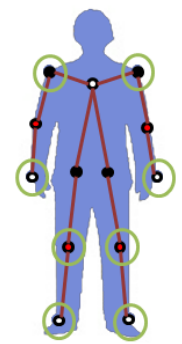
right elbow, a left wrist, a right wrist, a left hip joint, a right hip joint, a left knee, a right knee, a left foot and a right foot. Figure 2. A 13-joint human skeleton model. The eight markers used by the Samba motion capture system are indicated with larger circles around the joint. Red colored joints have one degree of freedom, and black colored joints have two degrees of